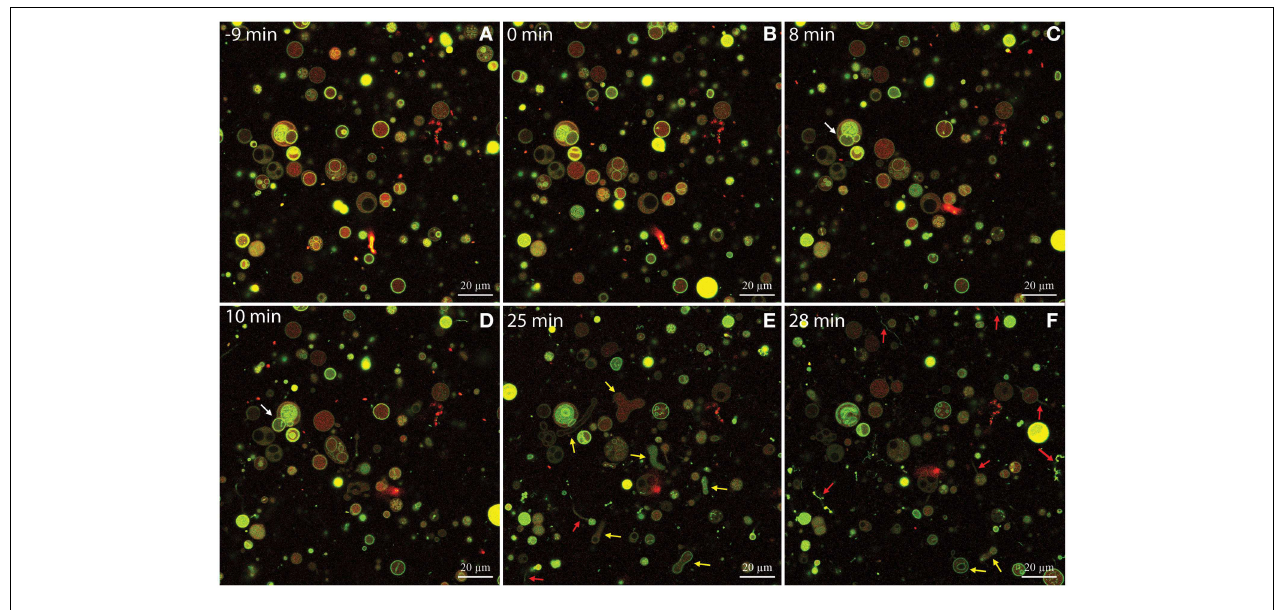
isoeugenol came in contact with GUVs (B) . (C–F) At later time-points the interaction between isoeugenol and GUVs results in four distinct structural changes of vesicles: Fluctuation of vesicles (not indicated in images), release of intravesicular GUVs (white arrows), affected GUV shape with diverse outcomes (yellow arrows), and tubular or bead protrusions from GUVs (red arrows). Bars correspond to 20 µ